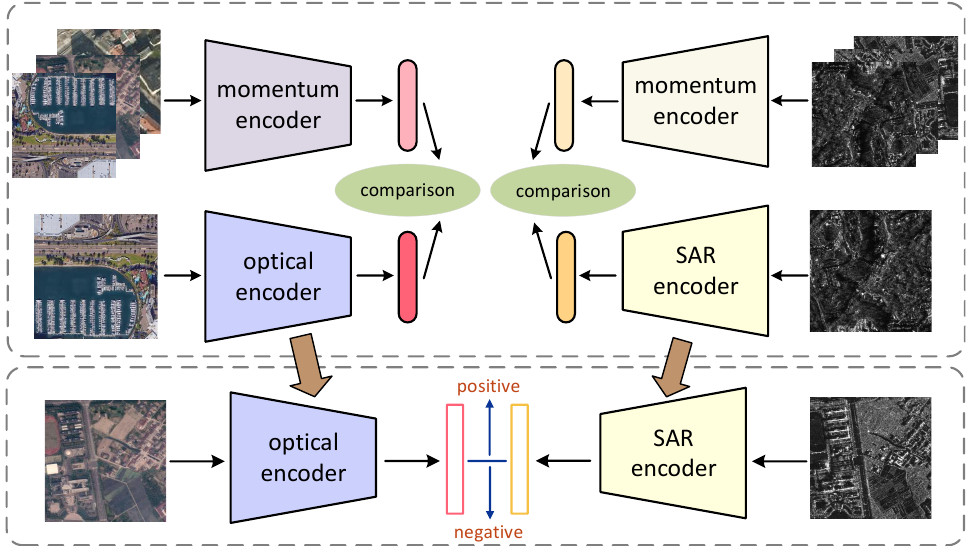
Figure 2. The overall process of models via MoCo pre-training transferred to BNN is described. The first box shows the process of applying MoCo to improve the representation learning ability of SAR and optical images separately. Then, the model is transferred to BNN to deal with the SAR-optical matching task in the second